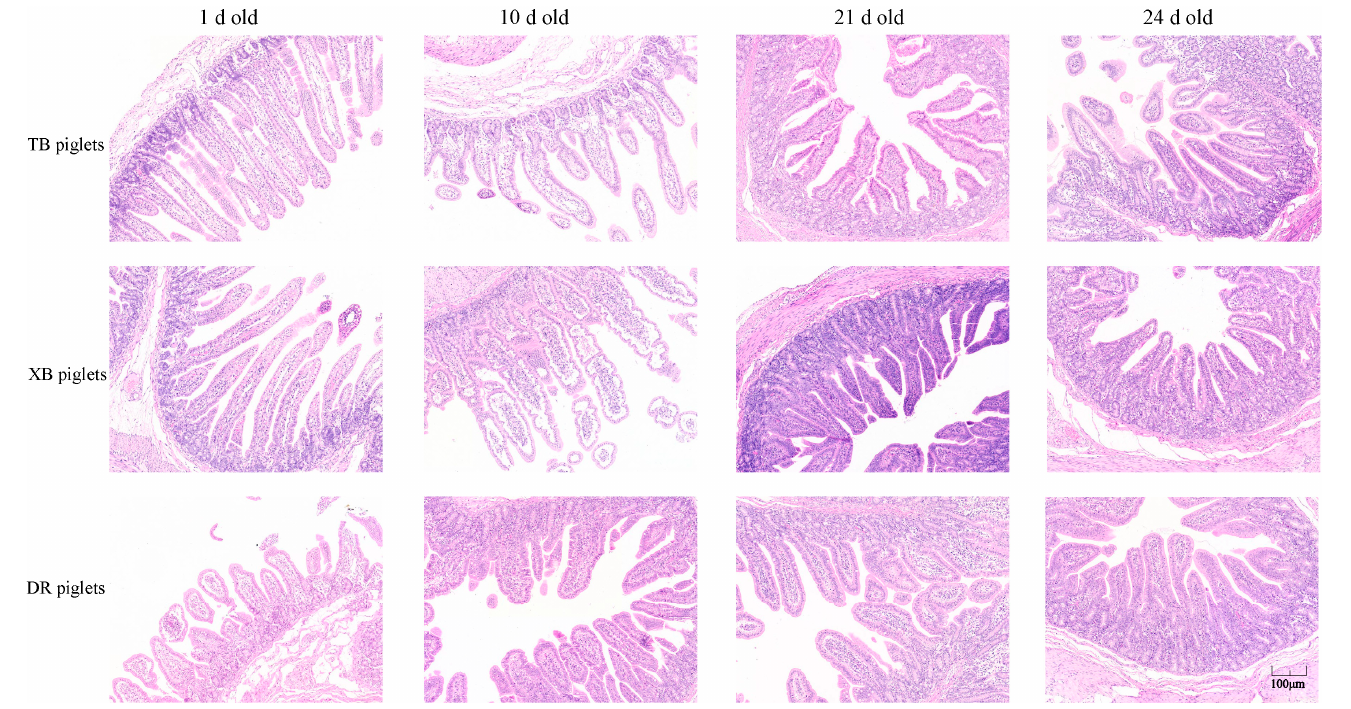
Figure 1. Comparison of jejunal histological appearance of three breeds of piglets at different ages ( n = 10). Sections were stained by hematoxylin and eosin. TB piglets, Taoyuan black piglets; XB piglets, Xiangcun black piglets; DR piglets, Duroc piglets. Scale bars, 40 ×. Table 4. Differences in the jejunal morphology of piglets at different ages.